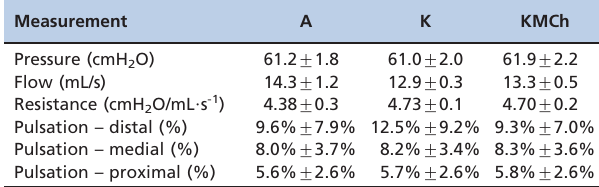
Table 1 - Control group measurements.